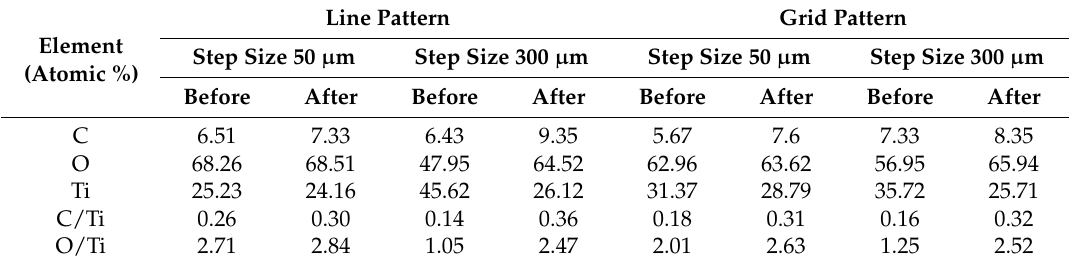
Figure 9. Top-view ( a – d ) field emission scanning electron microscopy (FESEM) images and ( e – h ) enlarged images of laser-machined surfaces with different step sizes 50, 300 µm for grid pattern, and 50, 300 µm for line pattern, respectively. Table 2. Energy-dispersive X-ray spectroscopy (EDS) results on burrs before and after heat treatment.